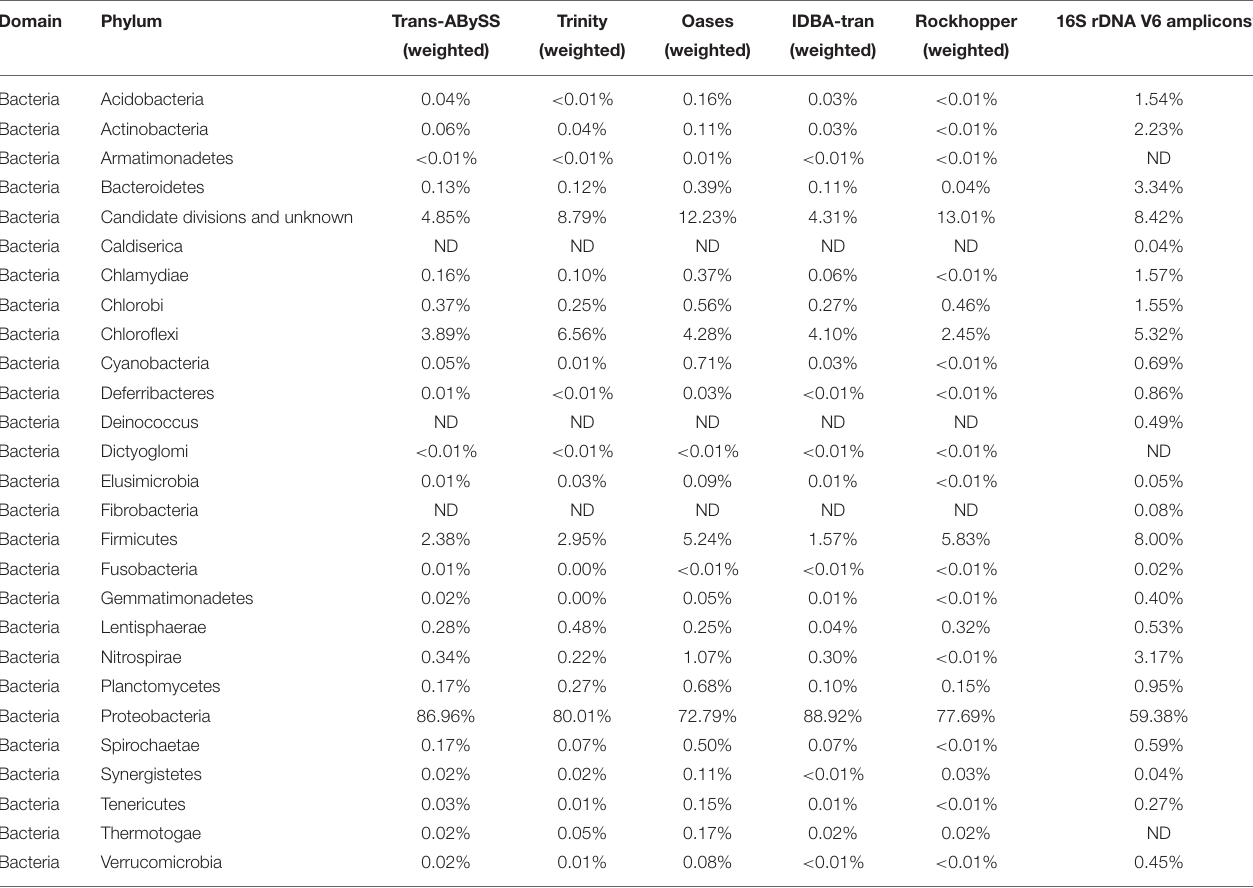
TABLE 3 | Taxonomic composition of bacterial phyla revealed by assembled transcriptomic data (this study) and 16S rDNA V6 amplicon data obtained from the same sample.